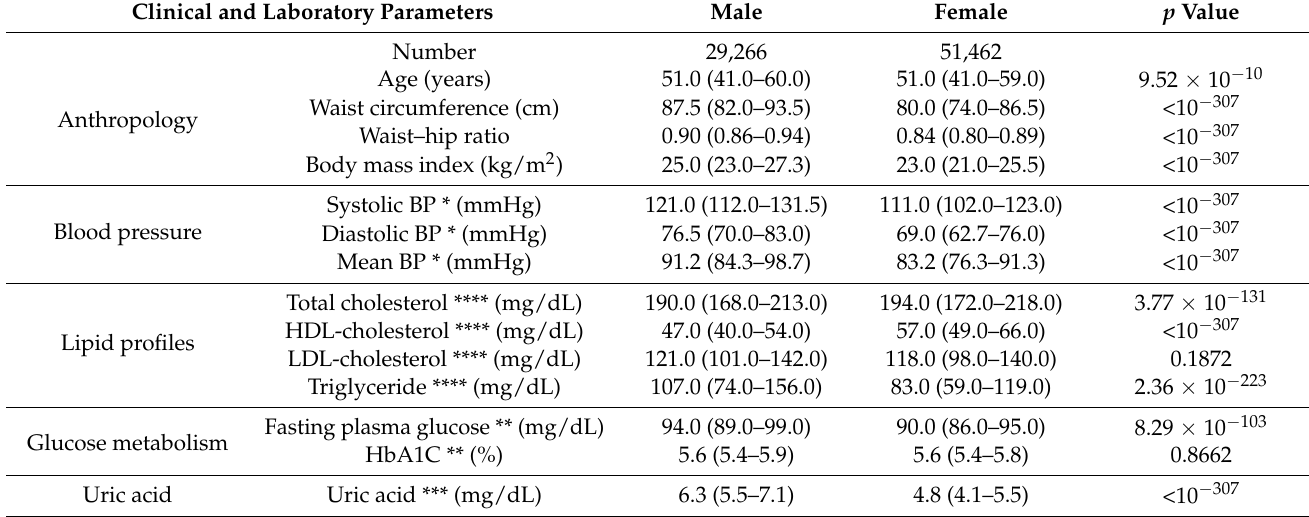
Table 1. Baseline characteristics of study subjects according to